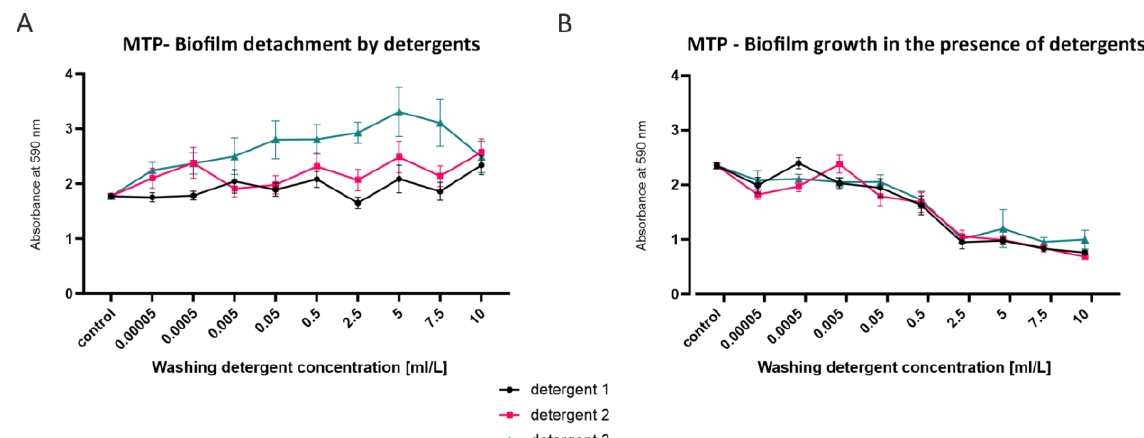
Figure 2. Biofilm detachment and biofilm formation of WM isolate B2.1 with liquid washing deter- gents. The microtiter plate assay followed by crystal violet staining was performed for quantification